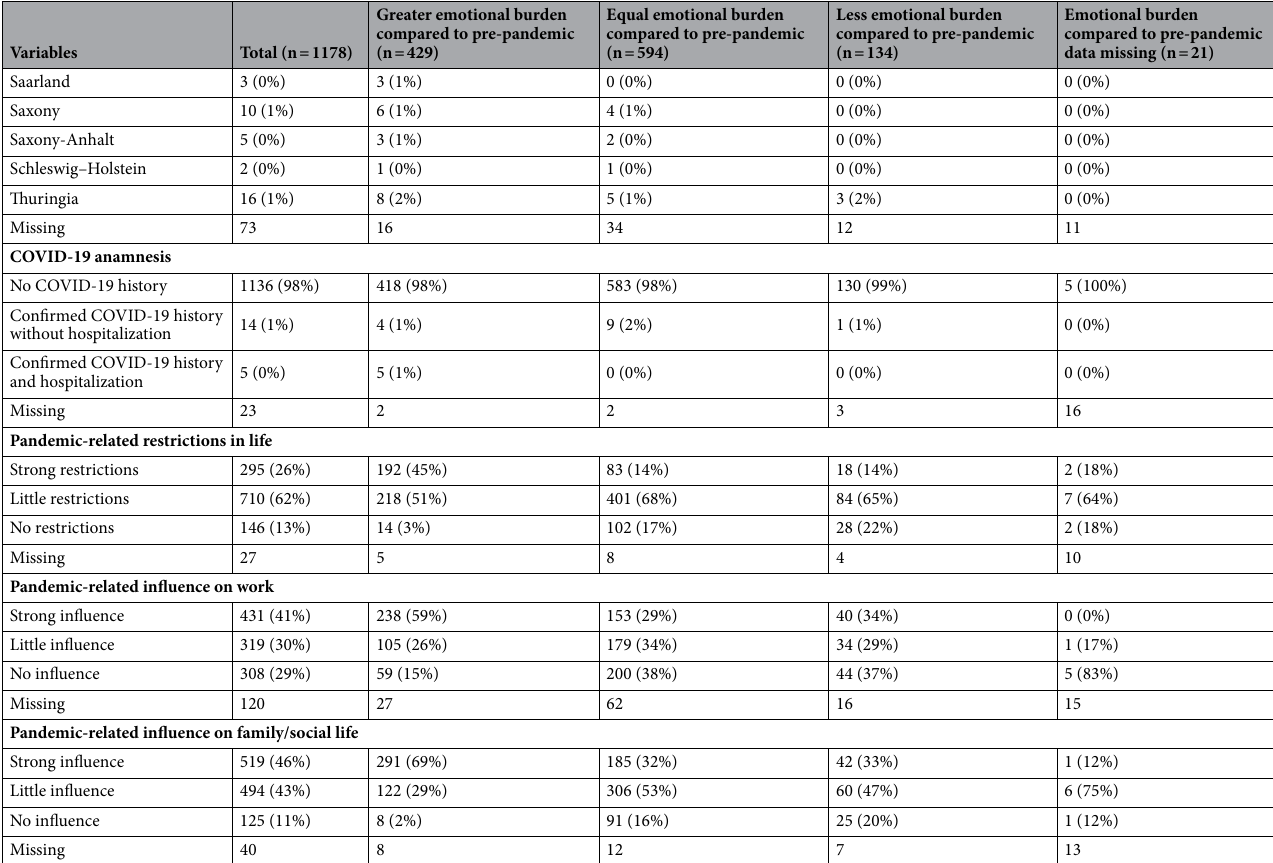
Table 1. Demographic and general data of the study cohort. n number of participants, COVID-19 coronavirus disease 2019, SD standard